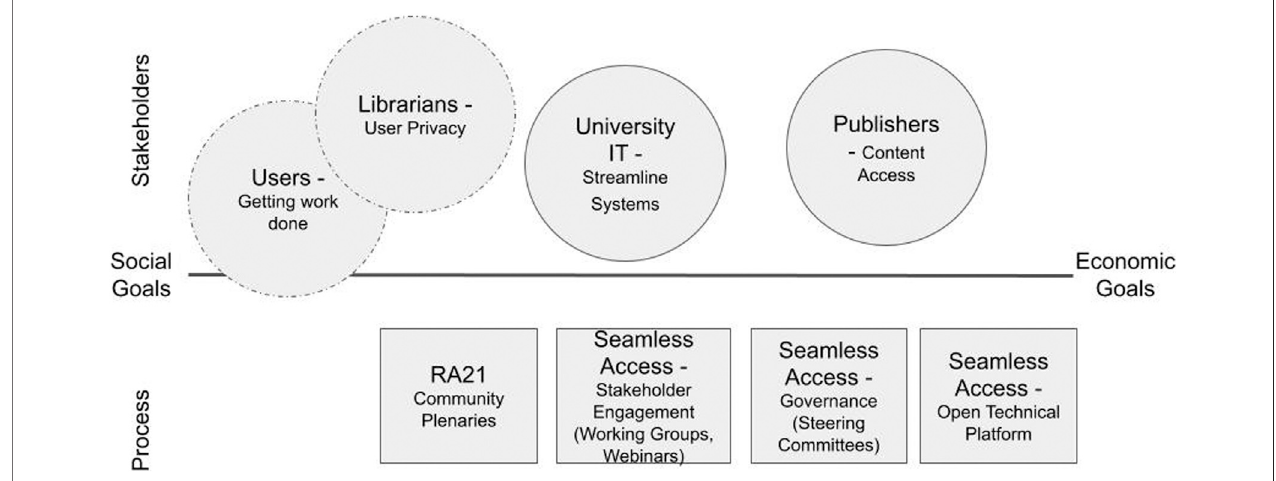
FIGURE 1 | RA21 and Seamless Access were driven by publishers, who have an economic incentive to improve content access. The initiatives employed community outreach tactics and developed a technical platform, but did not have a transparent multi-stakeholder governance process for deciding on requirements.